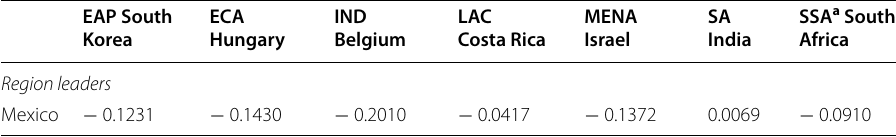
Table 5 Mexico’s infrastructure stocks compared to region